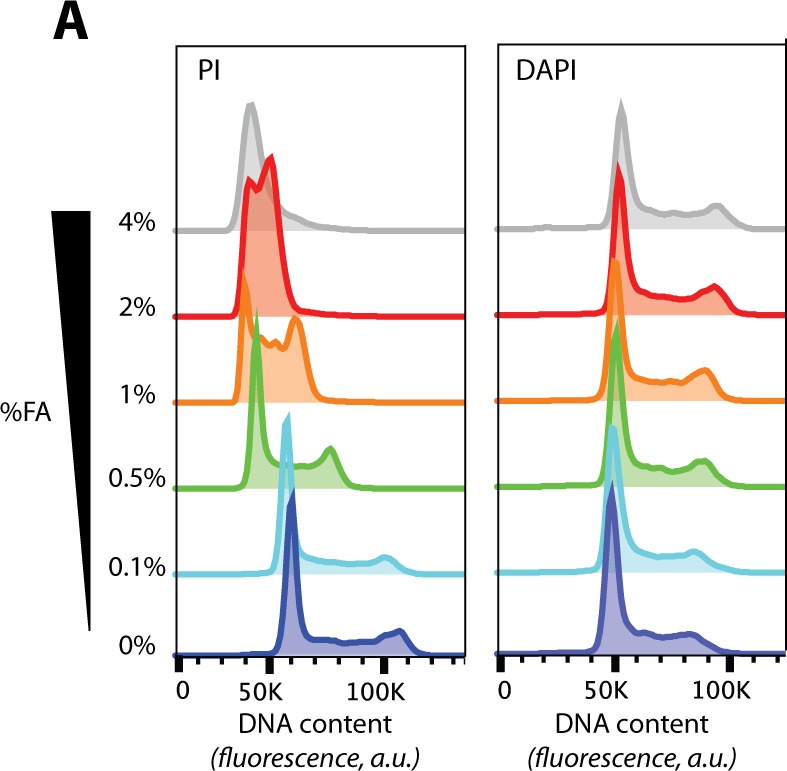
The effects of formaldehyde (FA) concentration on protein crosslinking and DNA staining.(A) DNA content histograms from flow cytometry of cells fixed with the indicated concentrations of FA and using either propidium iodide (PI, left), or 4',6-diamidino-2-phenylindole (DAPI, right), as the DNA-binding dye.